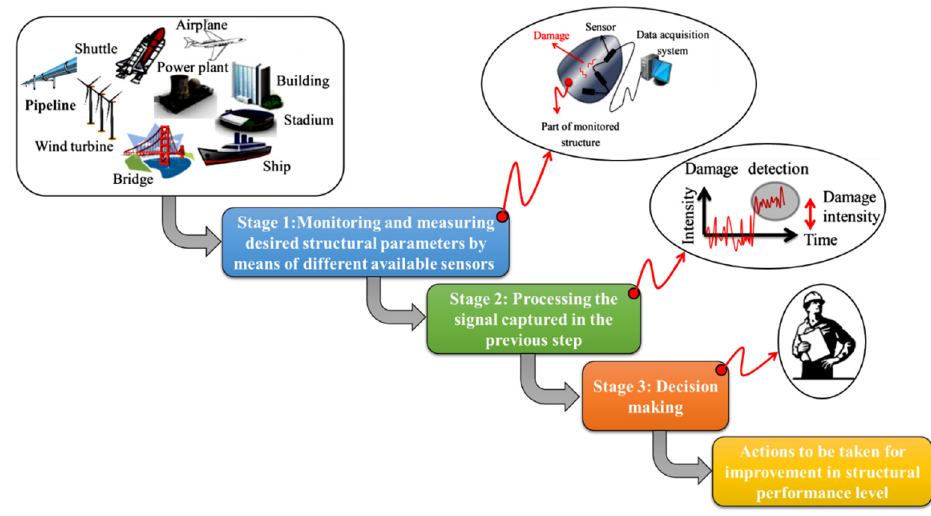
Figure 7. SHM system main stages.